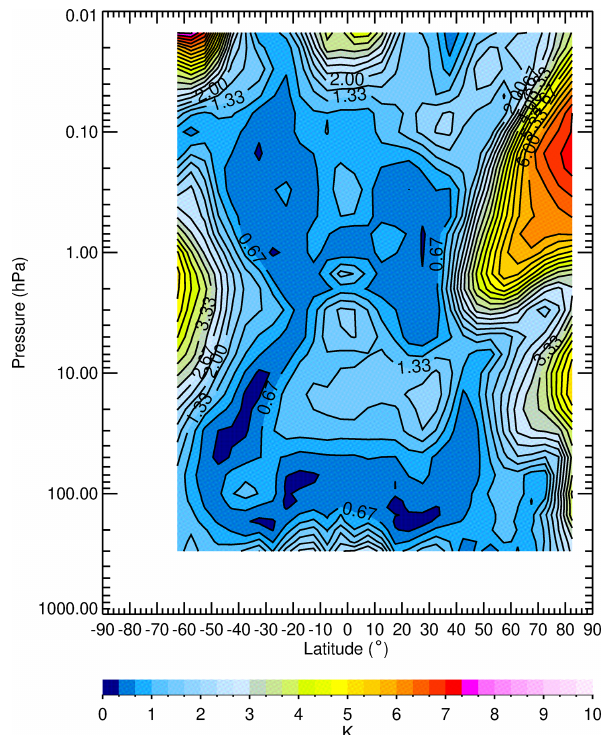
Figure 7. Average zonal (wave) standard deviation of temperature for March 1979. Contour interval is 0.33K.